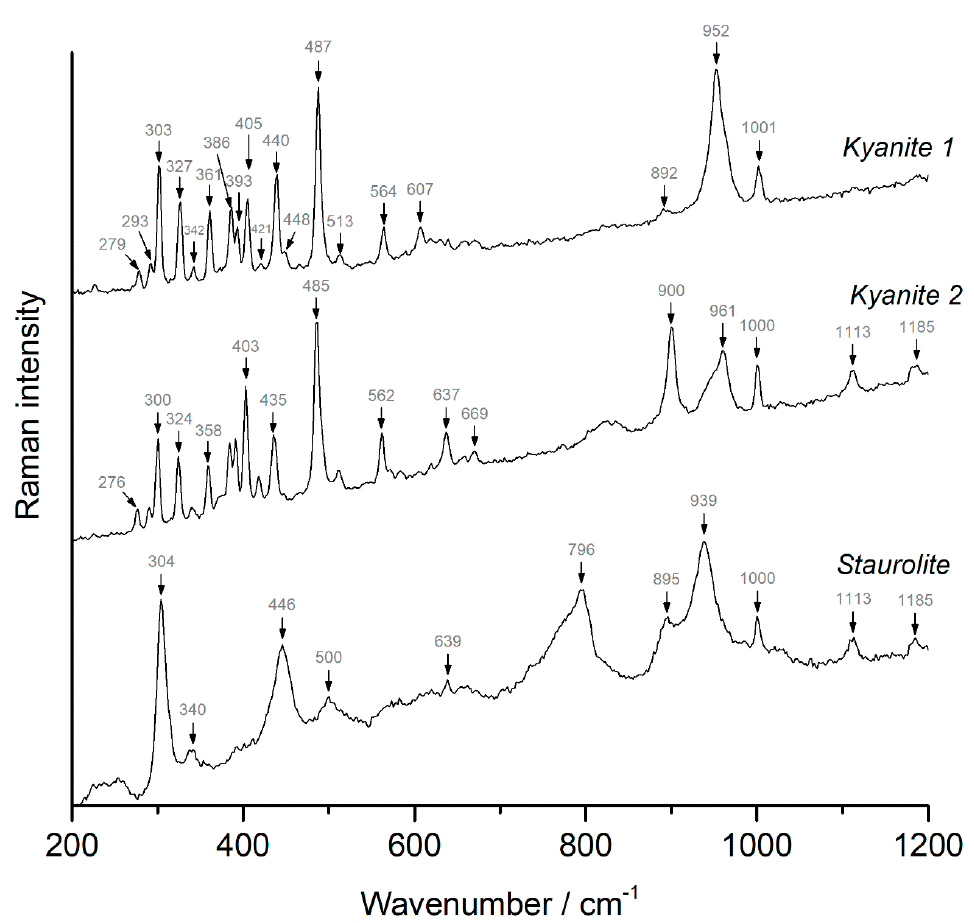
Figure 2. Raman spectra of kyanite and staurolite.